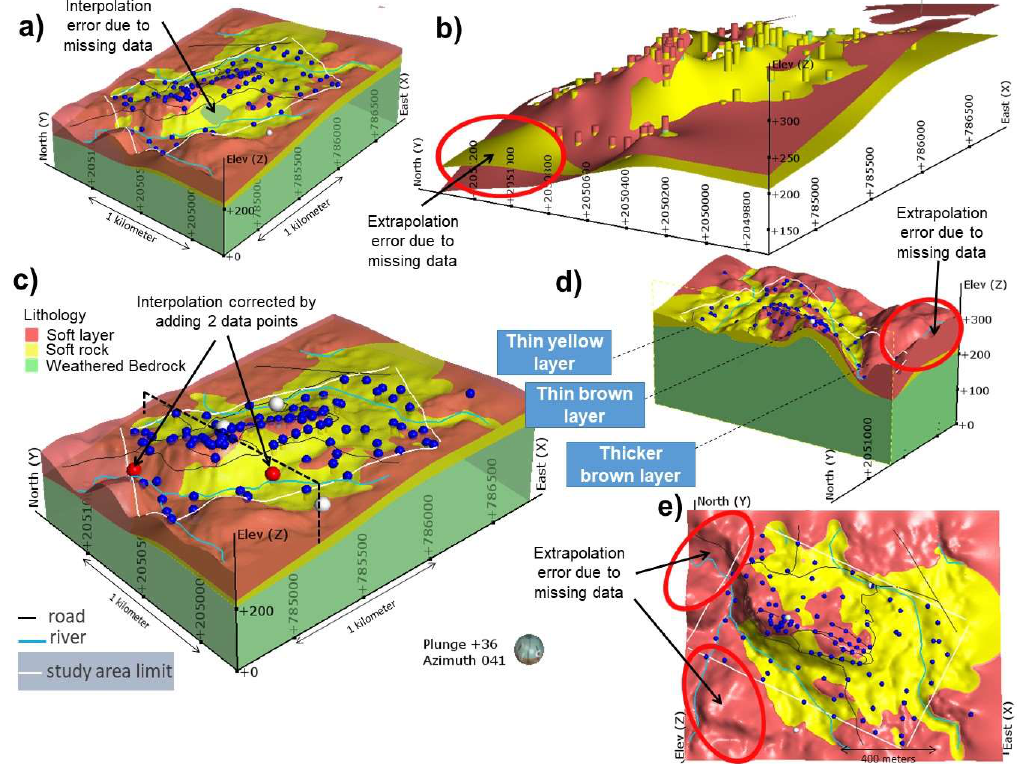
Figure 5. 3D Geomodel of the Gros-Morne site combining HVSR and multichannel analysis of surface waves (MASW) results. The three layers correspond to the assumed bedrock (green), to the soft rock on top of the bedrock (yellow layer with basis obtained through interpolation of the bottom of the log-bars); in some parts, a near-surface layer (brown) was added on top of the soft rock. ( a ) Initial model realized only with the recorded data, but presenting interpolation problems. ( b ) Layer-view of corrected model with HVSR log-bars with the contact surfaces corresponding to the interpolation of the layer contacts within the logs. ( c ) Volume-view of corrected model with recorded and added HVSR (blue balls = data; red balls = added); the white balls are seismic stations. ( d ) Same as ( c ), but along an E–W section. ( e ) Map-view of the geomodel. See red ellipse in some subfigures, marking the extrapolation problem that appears mainly outside the target area (highlighted by a white rectangle).